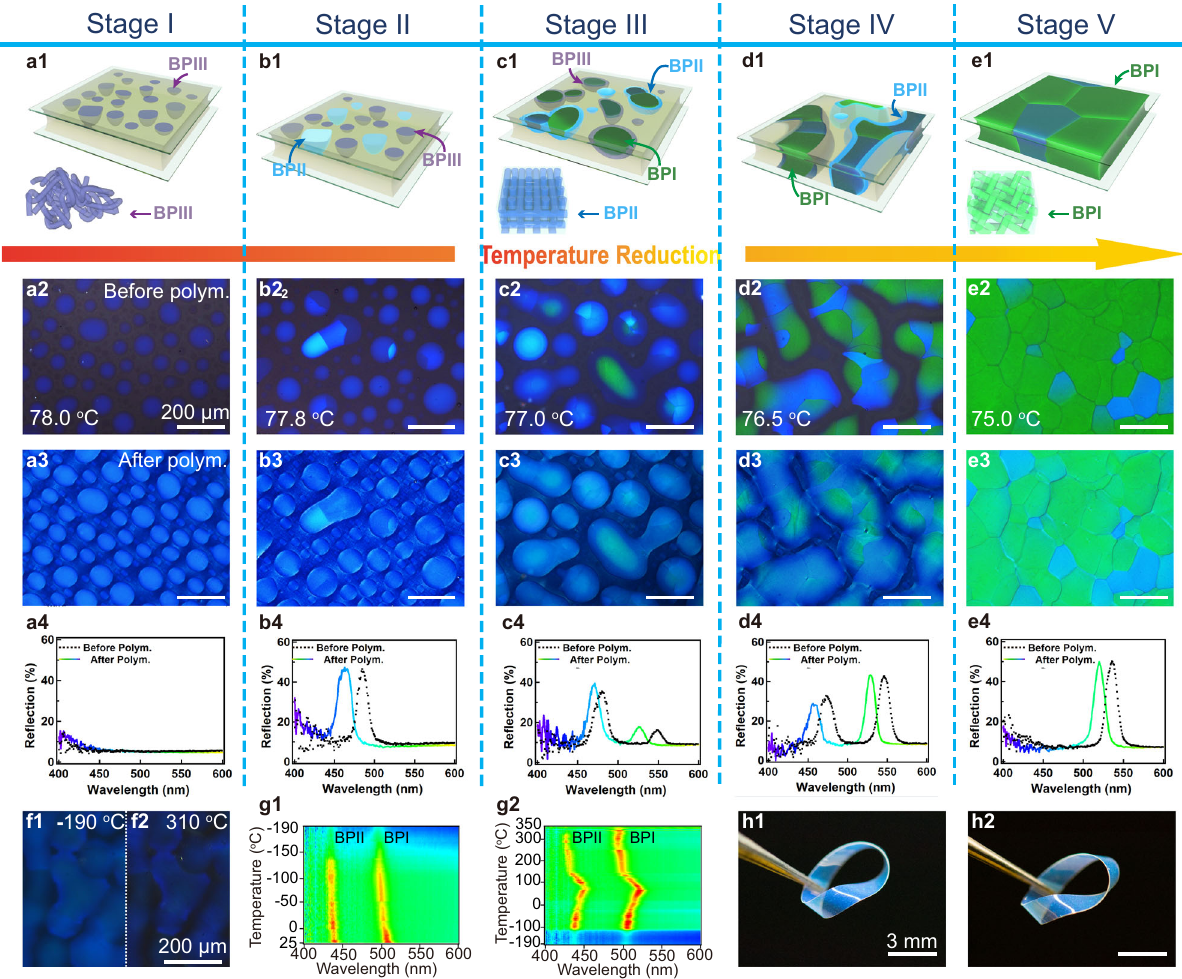
Fig. 1 Evolution of the phase-transition process of BPLCs and the temperature stability of polymer-stabilized BPLCs (PS-BPLCs) in Stage IV. a 1 – e 1 Schematic illustration of the phase-transition processes of a 1 BPIII in Stage I; b 1 BPIII domain and BPIII/BPII core-shell con fi guration, which coexist in